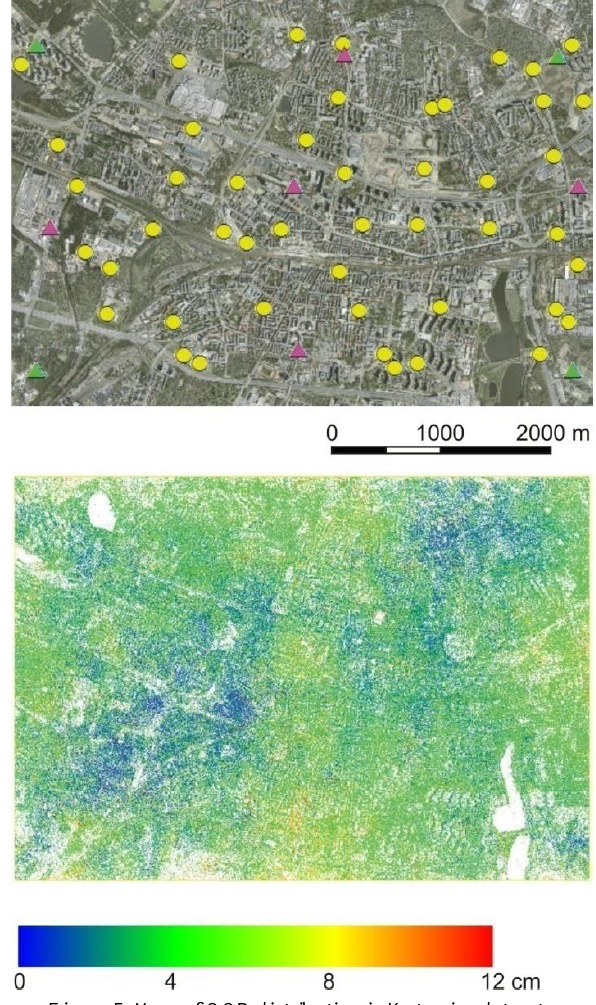
Figure 5. Map of GCP distribution in Katowice dataset. Markers: Yellow – Check points, Green – GCP in both variants, Pink – GCP only in variant with 9 GCPs. Spatial distribution of distances between tie points computed in variant with four and nine GCPs.